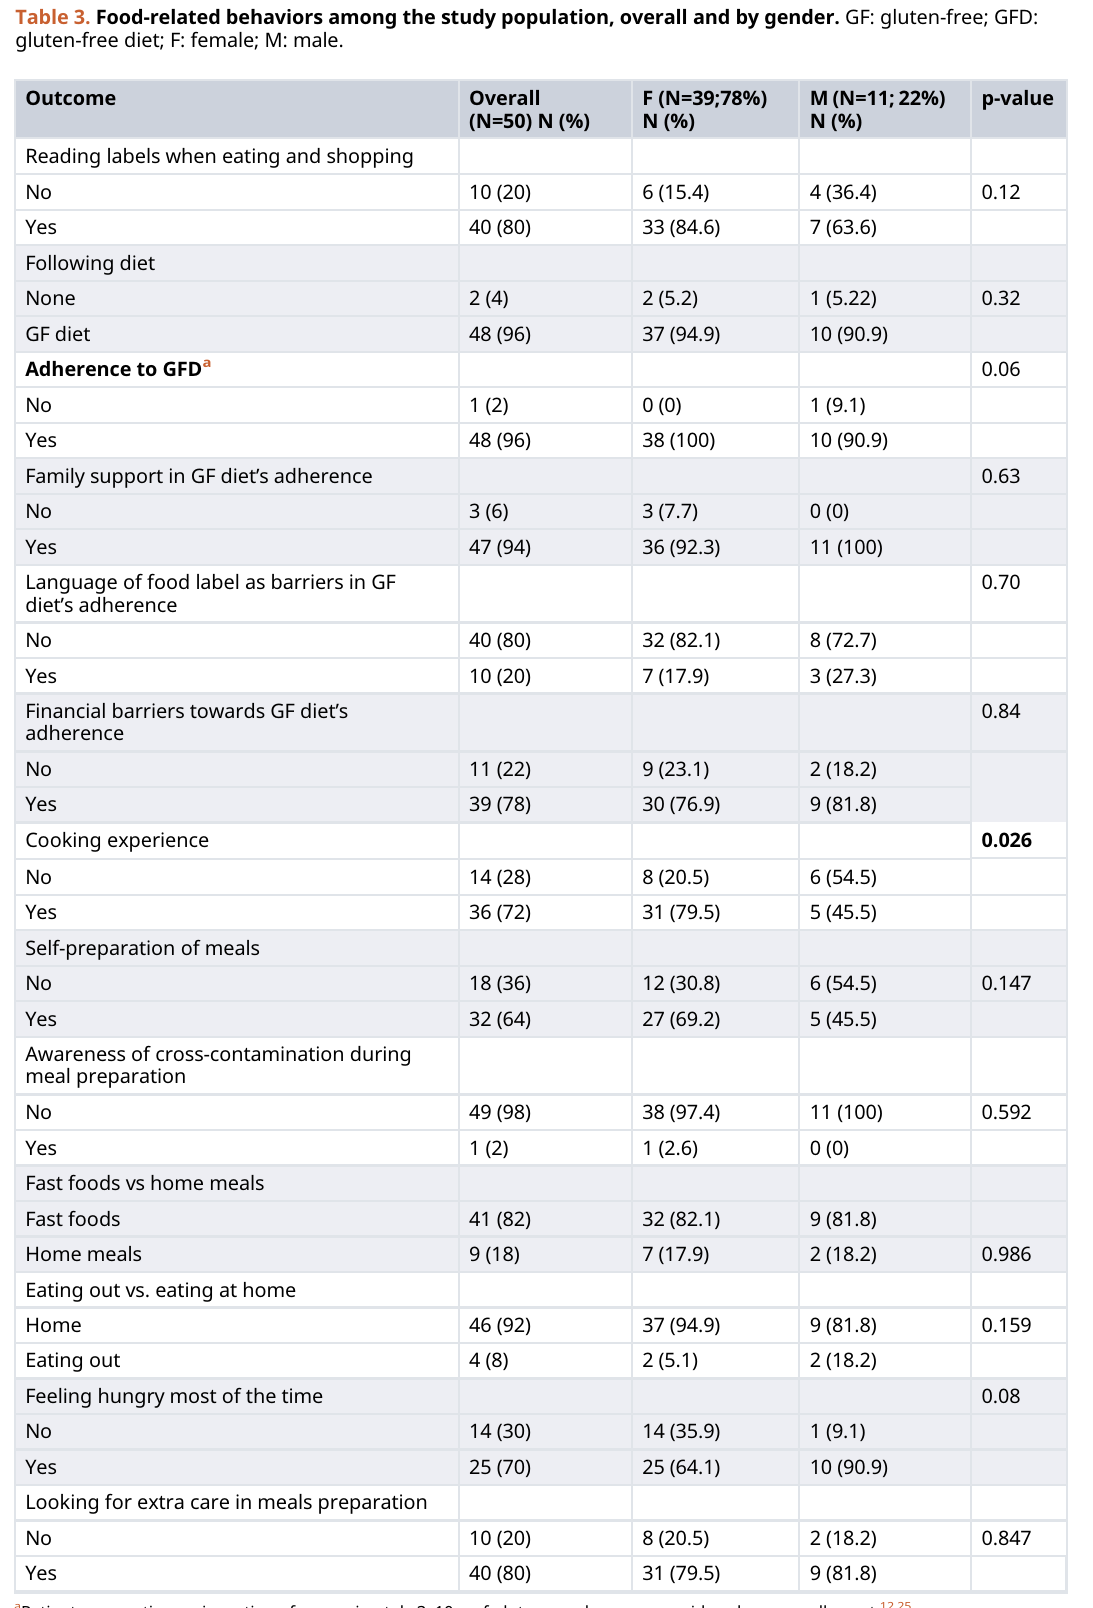
Table 3. Food-related behaviors among the study population, overall and by gender. GF: gluten-free; GFD: gluten-free diet; F: female; M: male. Outcome Overall